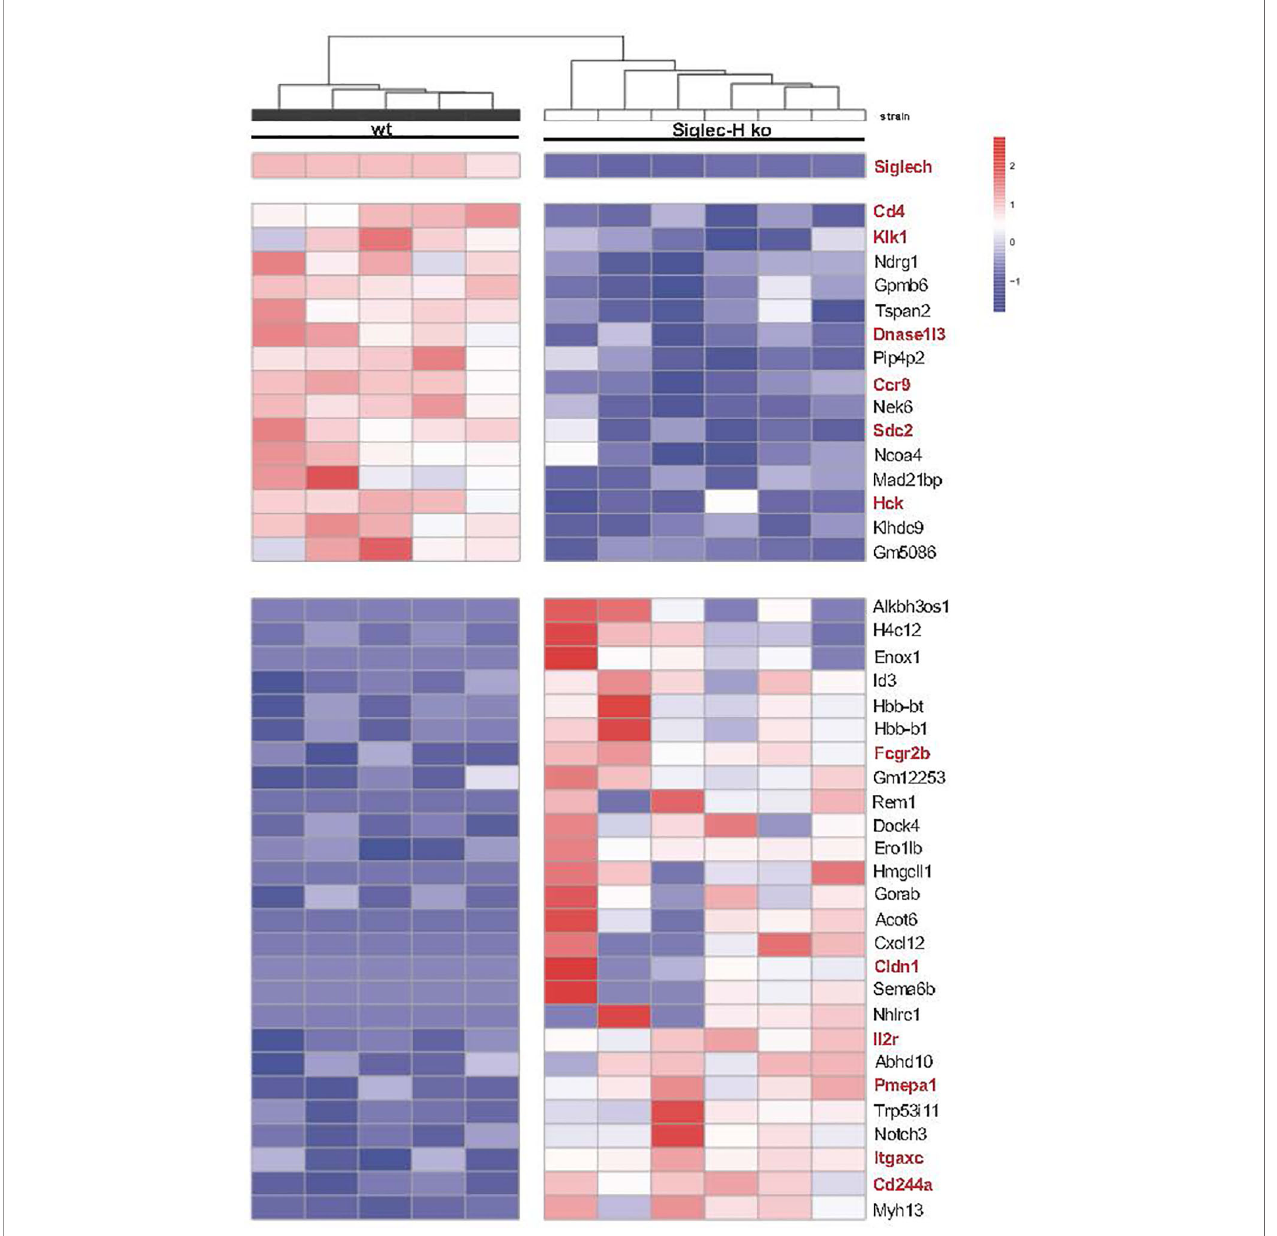
FIGURE 5 | RNA-sequencing analysis of naive wt and Siglec-H ko pDCs. Naive splenic pDCs from wt or Siglec-H ko mice were sorted as shown in Supplementary Figure 4B (purity: around 90%) and RNA isolated. Bulk RNA-Sequencing of probes was done by NGS. All detected counts per sequence were normalised to total counts in each probe. Heatmap depicting genes with an adjusted p value<0,05. Interesting genes connected to immune cell functions, signaling and autoimmunity are marked red. Blue colour indicates reduced expression, red colour increased expression of genes. One experiment, N = 5-6 per genotype. Mice were aged